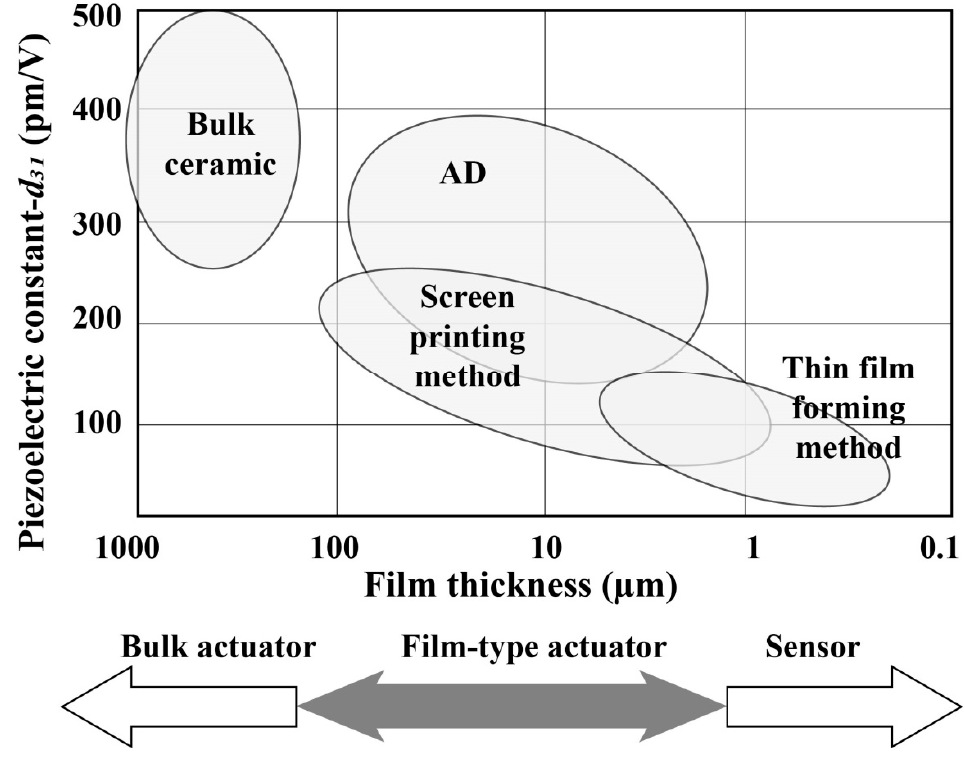
Figure 2. Piezoelectric film formation technologies and a comparison of piezoelectric properties.